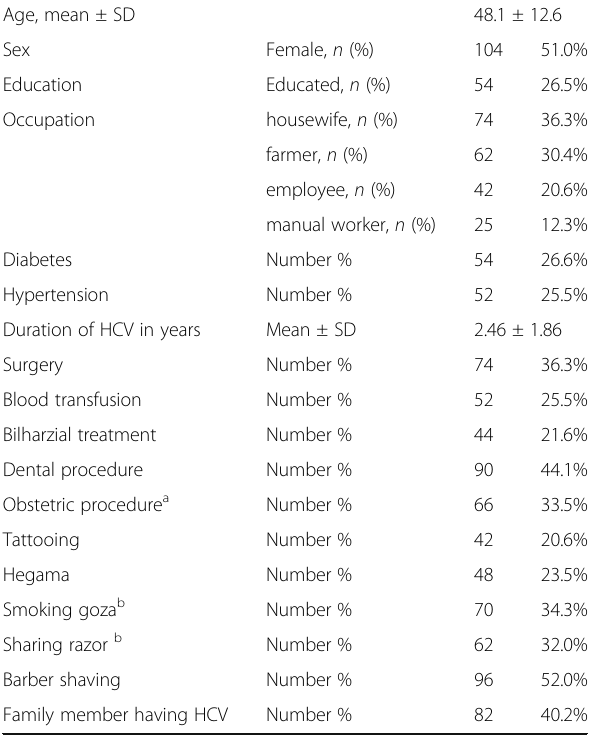
Table 1 Descriptive data of the hepatitis C patients: demographic and risk